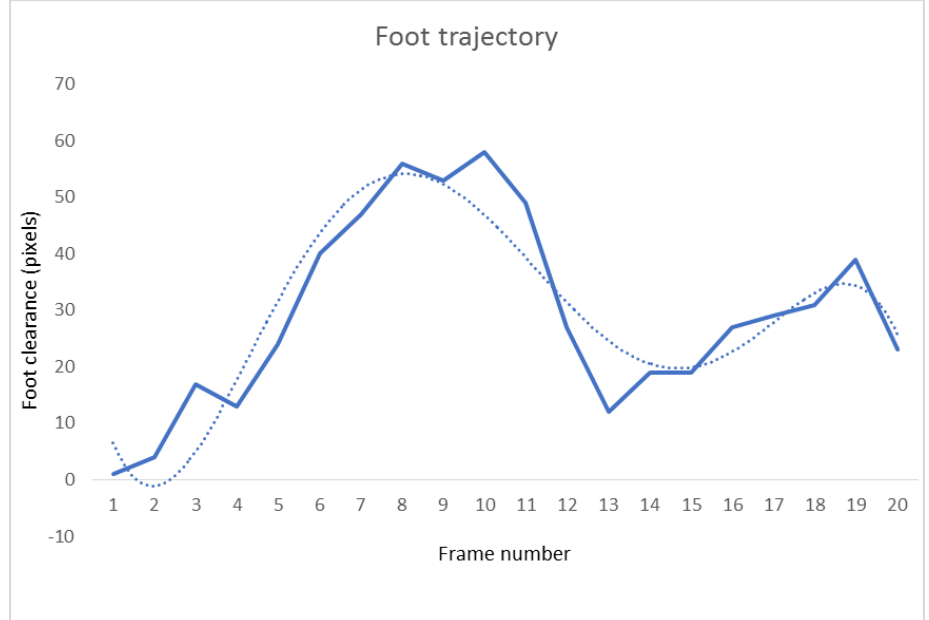
Figure 7. This figure shows the trajectory of the swing foot in one stride; the solid line shows the trajectory based on the lowest point on the detected swing masks and the dotted line shows the fitted 5th degree